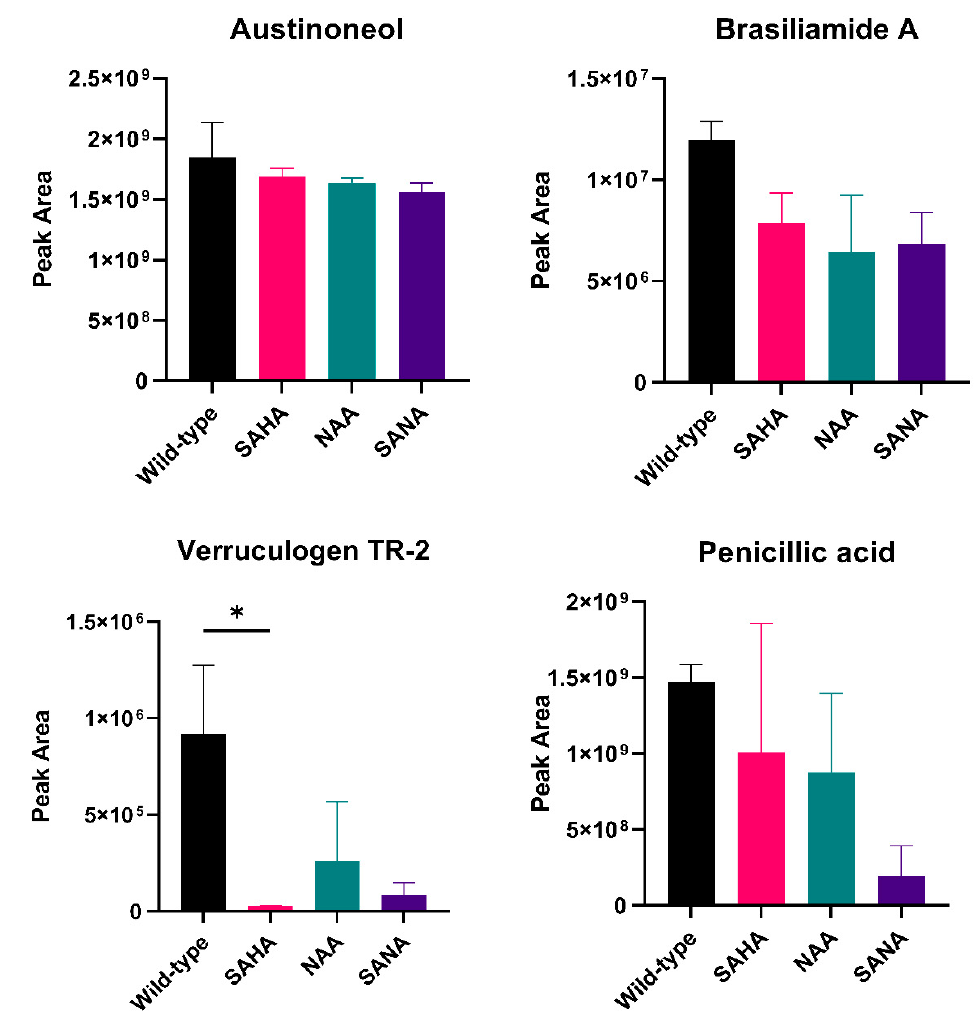
Figure 8. Relative quantification of detected metabolites in extracts from P. brasilianum grown in the presence of suberoylanilide hydroxamic acid (SAHA), nicotinamide (NAA), as well as a mixture of both (SANA). The data represent the average value of two replicates. The error bars represent standard deviation, * p ≤ 0.05 (one-way ANOVA—Tukey’s test, significance level 0.05).